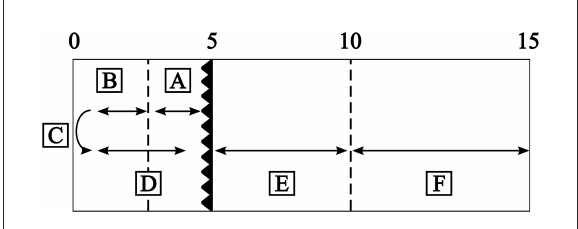
FIGURE1 Graphical representation of the temporal variables and distances used for calculating the performance measures and the technical variables of interest. A: from 5 m-in until 3 m-in to the wall, B: from 3 m-in to the wall until head down before the turn, C: duration of the tumble turn and push-off (starting with the head underwater until the feet lose contact with the wall), D: the feet having lost contact with the wall until the hip crosses the 5m mark, E: from 5 m-out of the wall until 10 m-out of the wall and F: 10 m-out of the wall until 15 m-out of the wall.